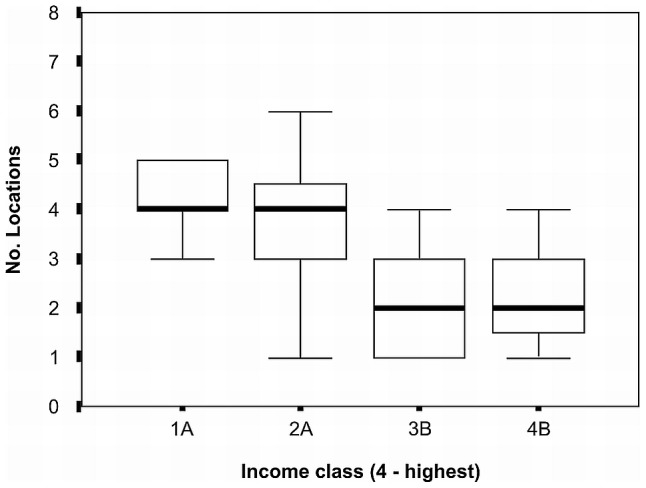
Number of locations for timber collection by income class for Amerindians, North Rupununi, Guyana.Columns with the same letter do not differ according to Tukey's multiple range test.